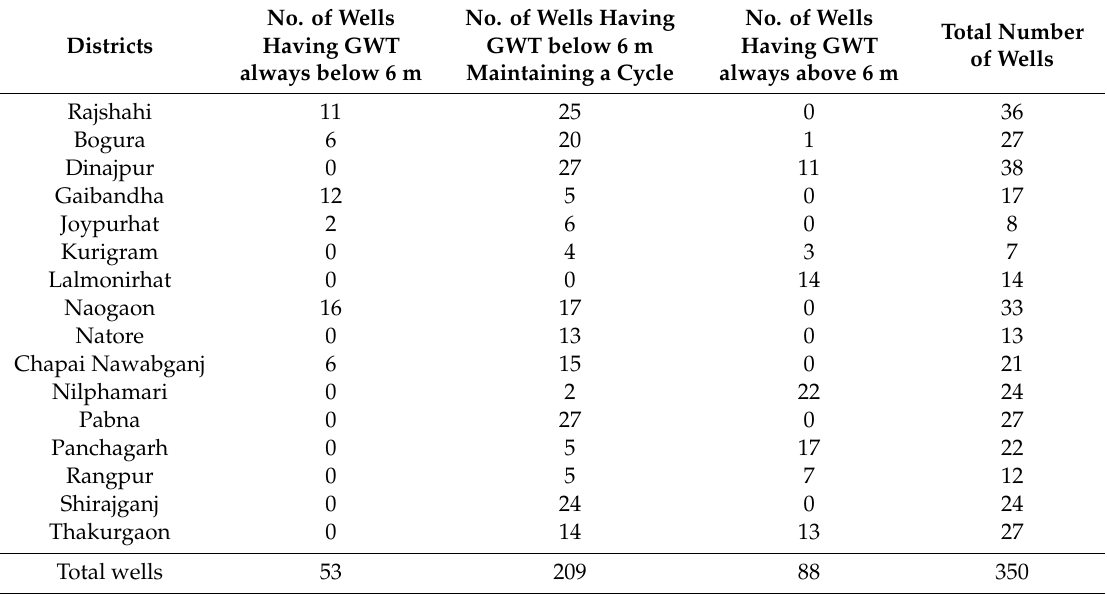
Table 5. Distribution of the groundwater table (GWT) monitoring wells in 16 districts of the North-West hydrological region of Bangladesh based on suction lift limit (6 m) of